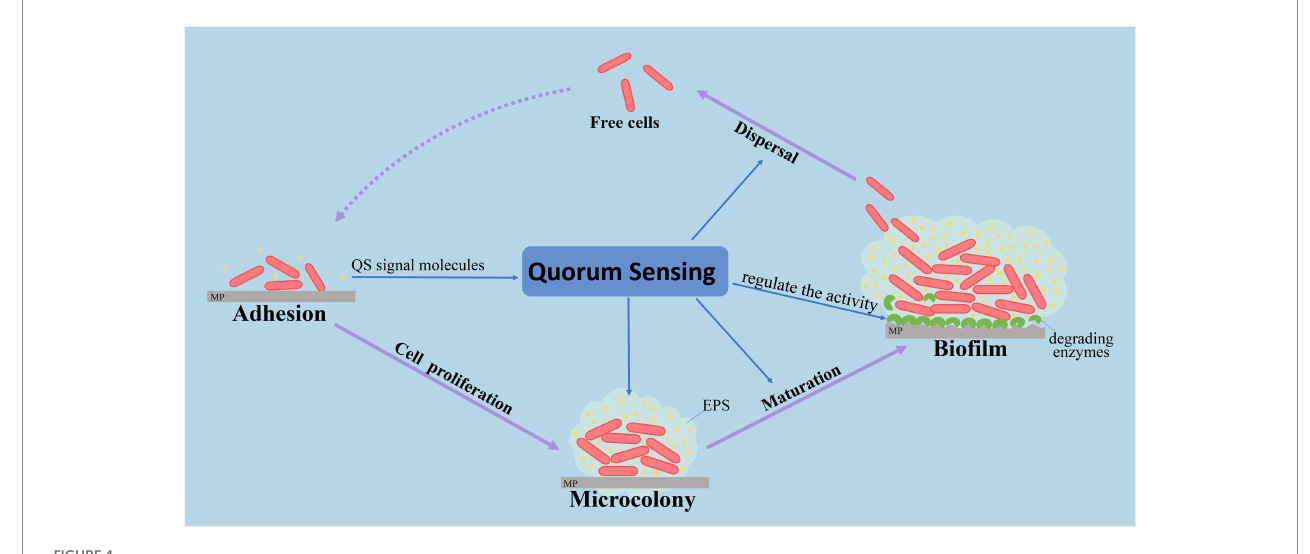
FIGURE 4 The regulation of quorum sensing in the